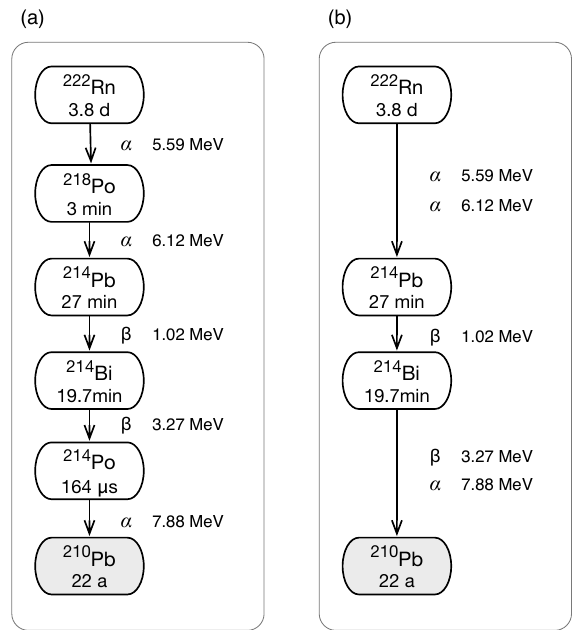
Fig. 1. (a) Radioactive decay of radon and its progeny. The half- life, decay type and decay energy of each species are also listed. (b) The simplified decay chain considered in our simulations.